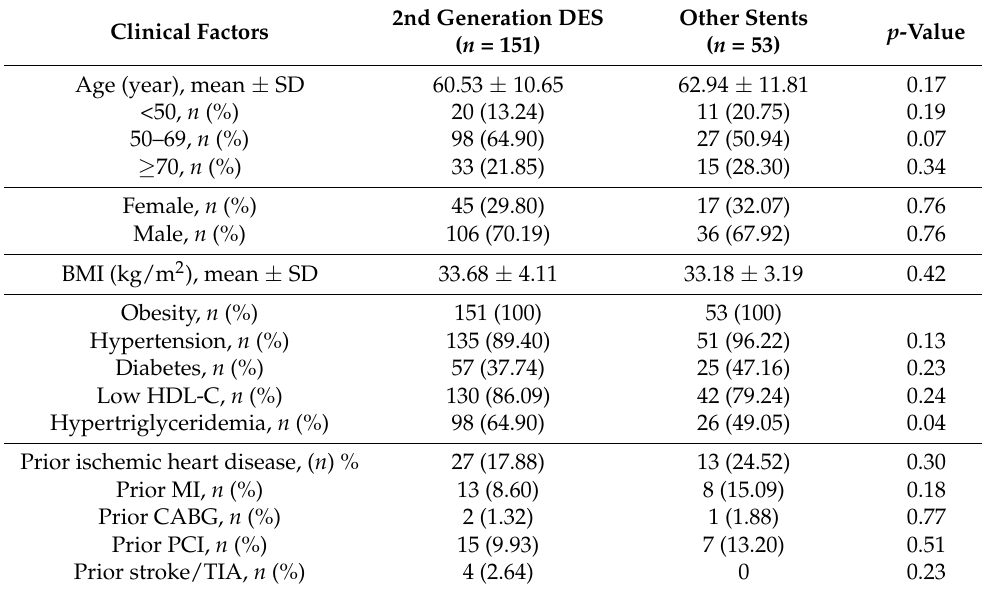
Table 1. Baseline characteristics of patients according to stent type